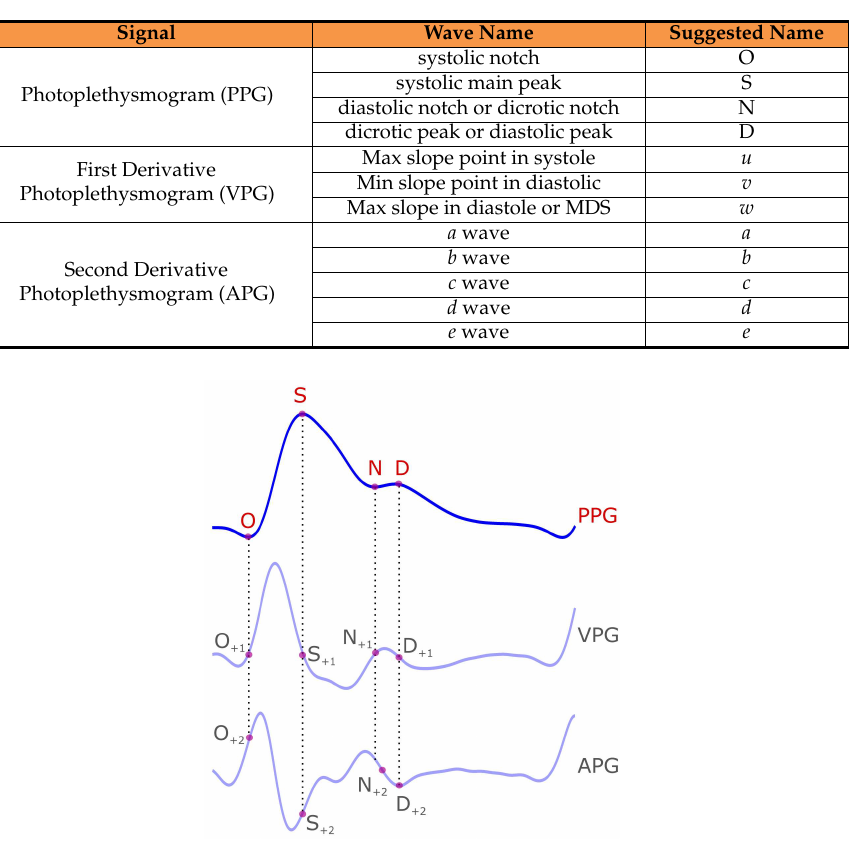
Table 1. Suggested wave names in photoplethysmogram signal and its derivatives.